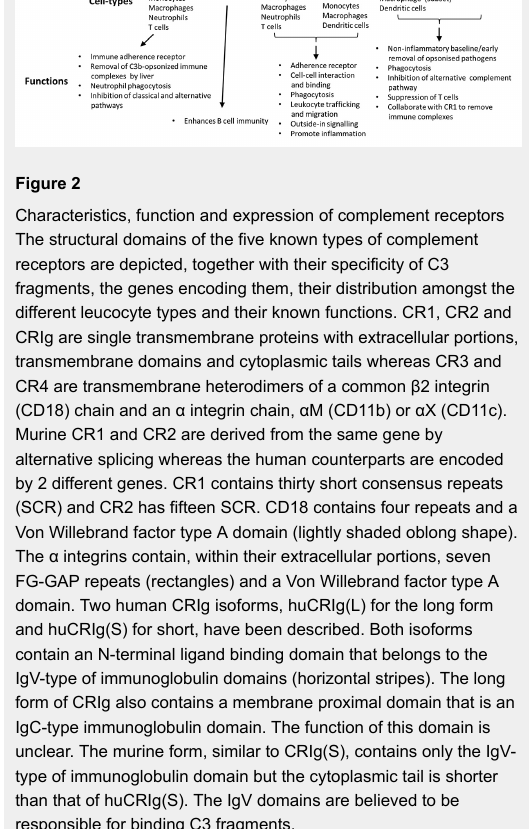
domain. Two human CRIg isoforms, huCRIg(L) for the long form and huCRIg(S) for short, have been described. Both